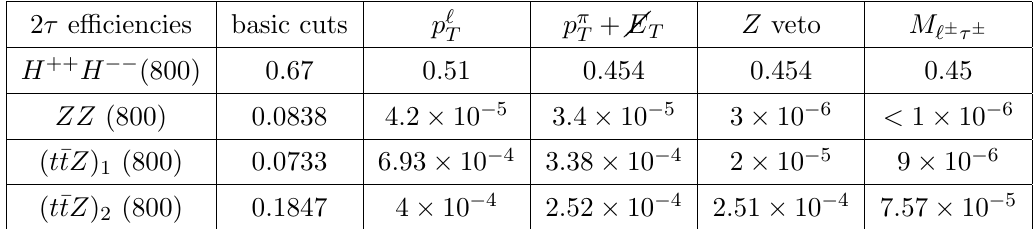
Table 3 . The cut e(cid:14)ciencies for 2 (cid:28) signal ( pp ! H ++ H (cid:0)(cid:0) ! ‘ + (cid:28) + ‘ (cid:0) (cid:28) (cid:0) ) and the SM backgrounds after accumulated cuts with (cid:28) (cid:6) ! (cid:25) (cid:6)